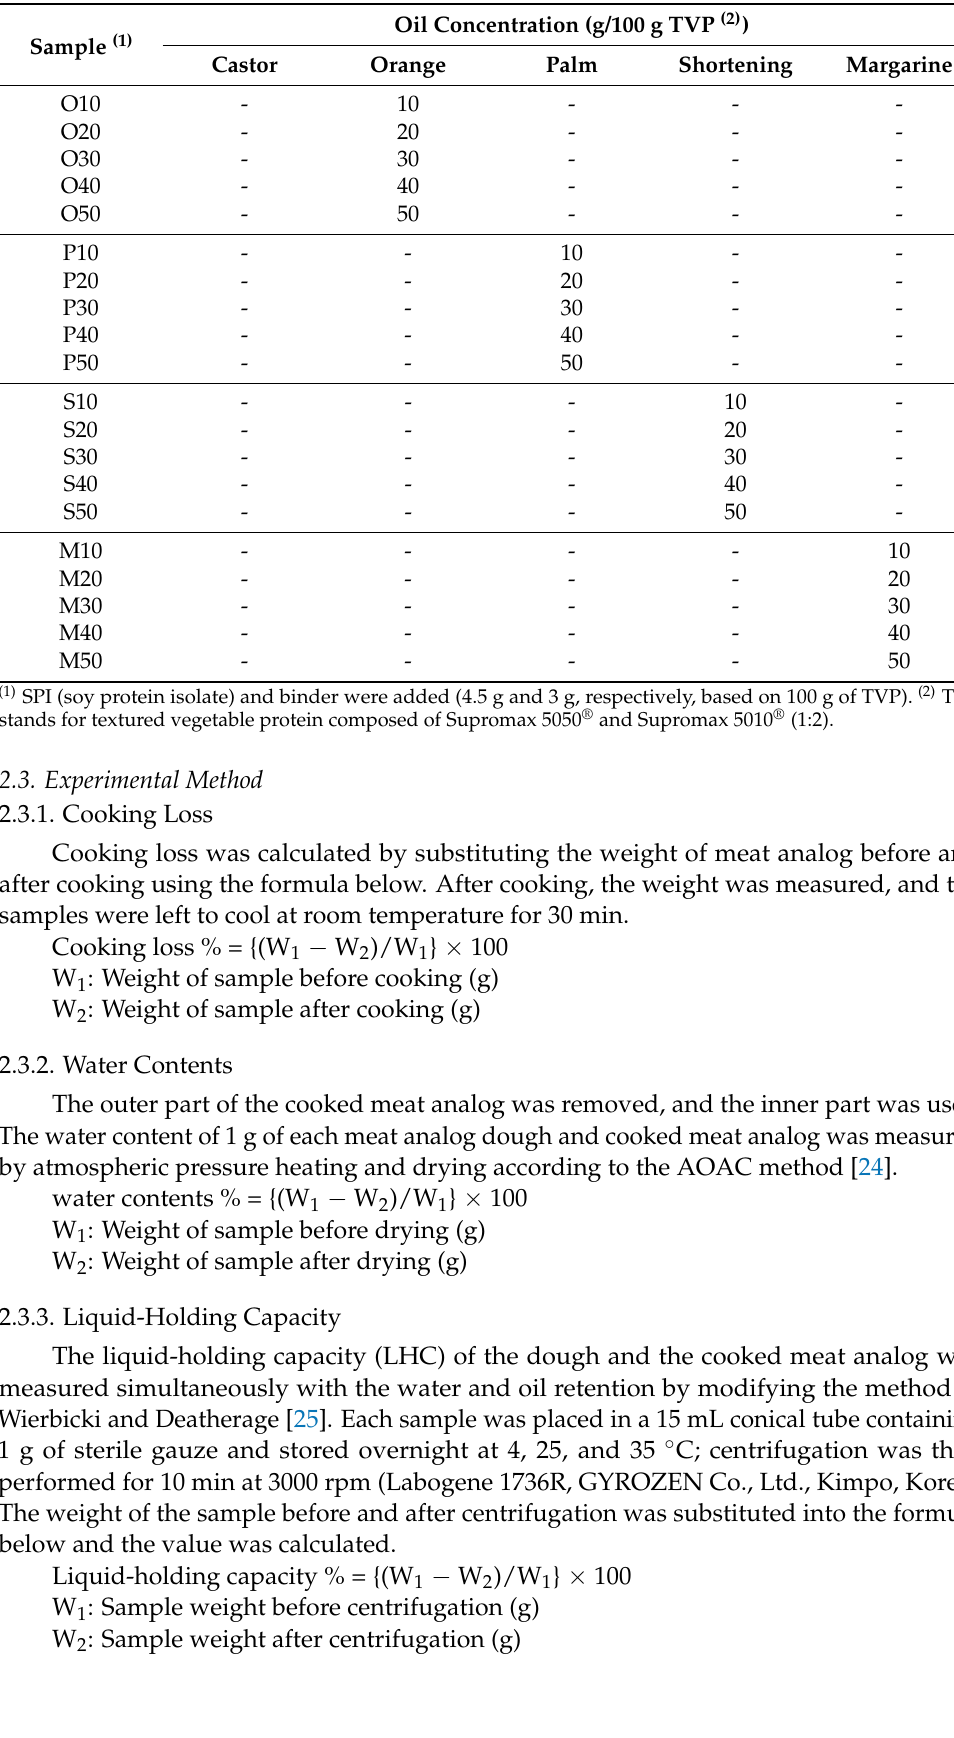
Table 1. Cont. Sample (1)